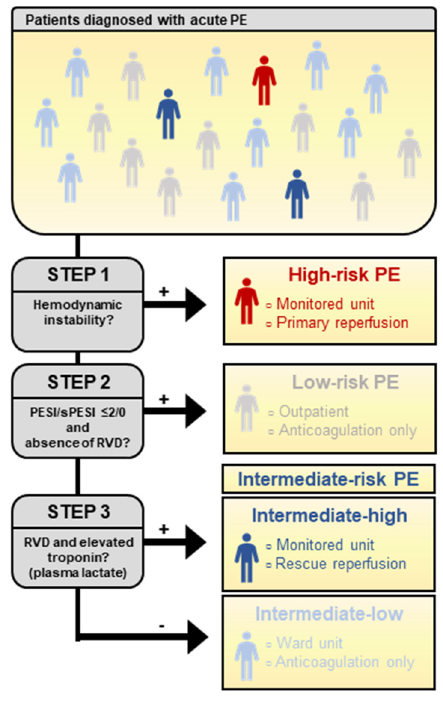
Figure 1. Step-by-step risk stratification in acute pulmonary embolism .